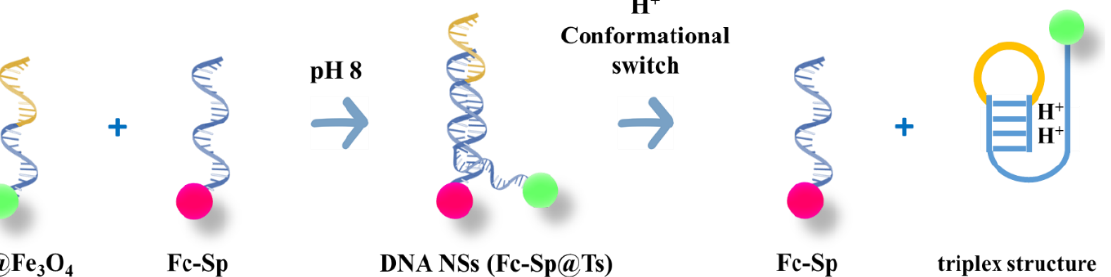
Figure 2. Schematic diagram of the conformational switch of pH-responsive DNA nanostructures (DNA NSs, Fc-Sp@Ts) induced by hydrogen ion (H + ) released from PTP1-based LAMP reactions